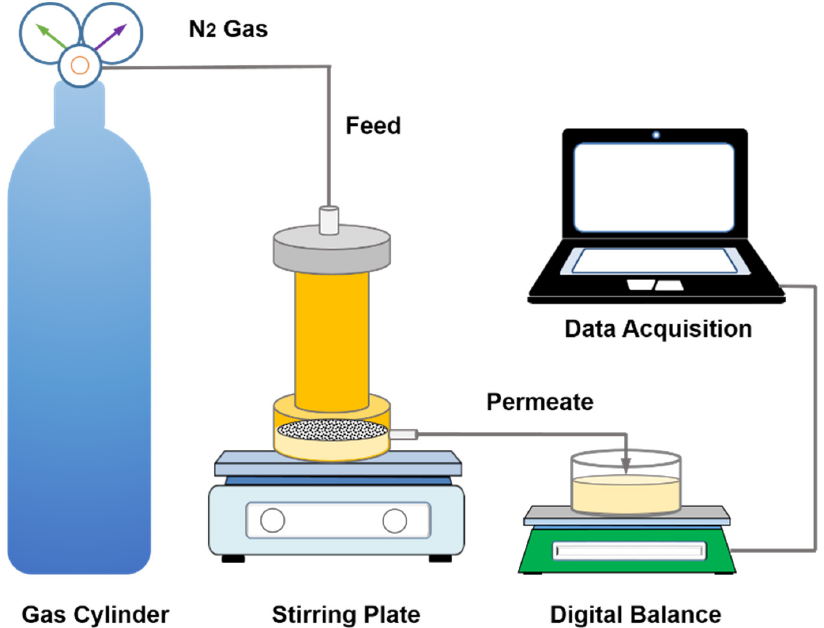
Figure 2. Schematic view of the dead-end nanofiltration (NF) setup. All of the filtration tests were conducted at 25 °C. The operating pressure and stirring rate were between 250 psi to 350 psi and 500 rpm to 1500 rpm, respectively.